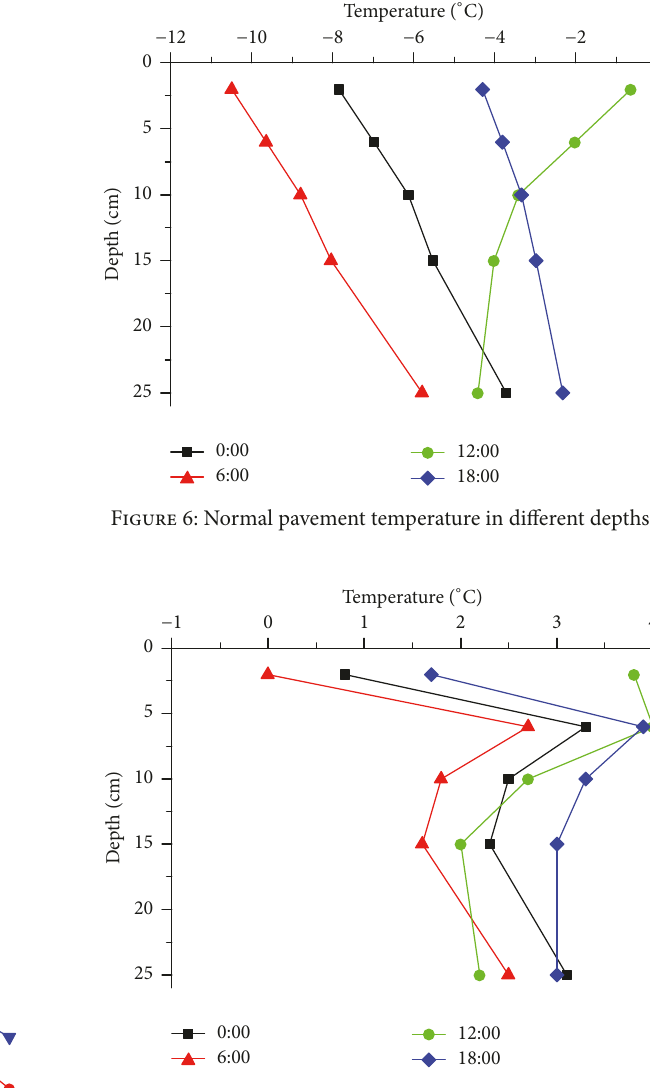
Figure 7: Heat pipe pavement temperature at different